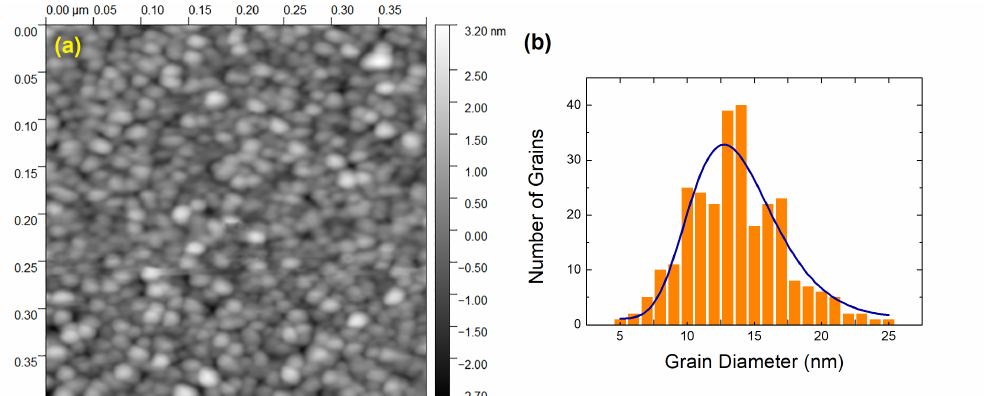
Figure 1. ( a ) AFM image recorded on the surface of an 8.9 nm thick PdO film. The roughness scale is introduced on the right-hand side of the image. In ( b ), the corresponding statistics of the grain size together with log-normal fitting is provided.